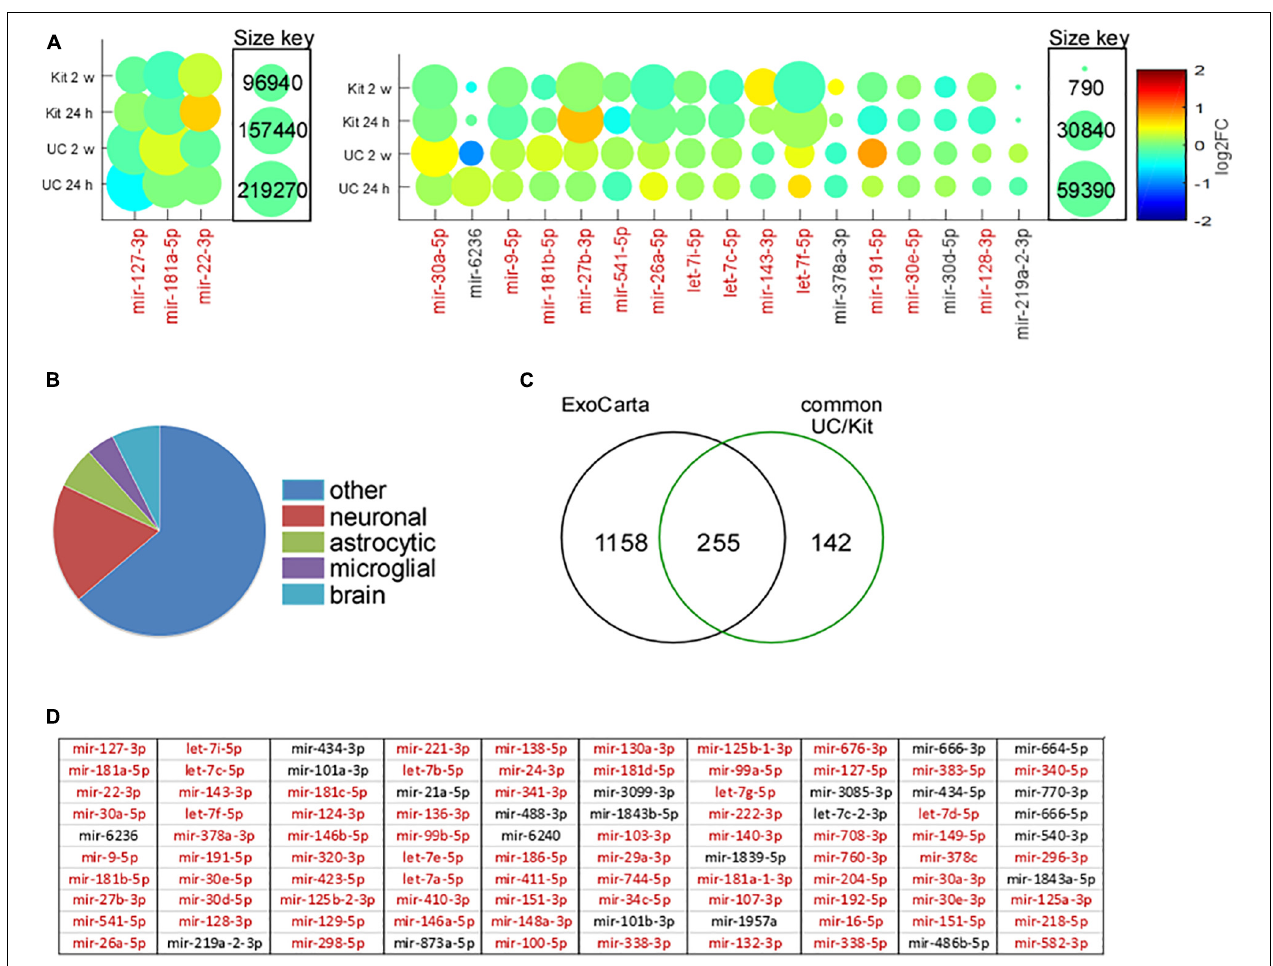
FIGURE 6 | Abundance, cell origins, and ExoCarta analysis of EEF miRNA content. (A) Amounts of miRNAs identified by small RNA sequencing of EEFs from mouse hippocampus. MiRNAs are ordered on a Matlab-based visual graphic, according to average log2FC across all samples, from highest to lowest abundance. The size of the visual graphic bubble shows the number of reads (CPM) of each miRNA detected in the samples and its color represents the log2FC in KA relative to PBS control levels. Presented are the top 20 miRNA in the UC-derived EEFs, of which 16 are common across all 24 samples (in red). (B) Pie chart depicts the assignment of miRNA based on likely cell type for the common 397 miRNAs detected in both UC and kit EEFs. (C) Venn diagram showing overlap ( ∼ 64%; 255 of 397) of the detected miRNA with those listed in the exosome contents database, Exocarta. (D) Top 100 miRNA (most abundant based on average across all 12 samples in UC) expressed in EEFs from both UC and kit. The miRNAs colored red are listed in